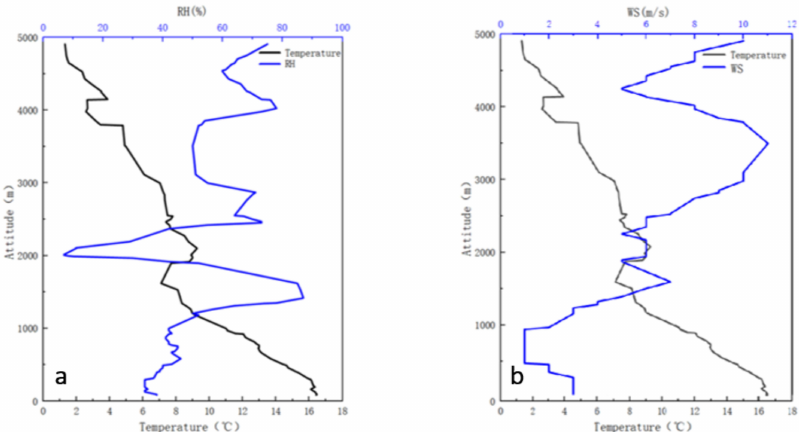
Figure 7. Vertical profiles of the temperature, RH, and WS over Jinan (28 March 2021): ( a ) temperature and RH profiles on 28 March 2021; ( b ) temperature and WS profiles on 28 March